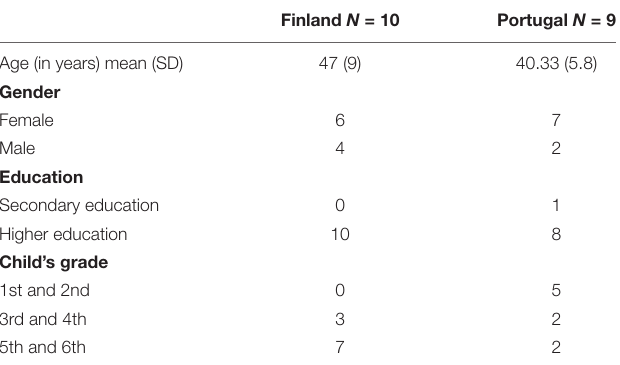
TABLE 1 | Participants’ background